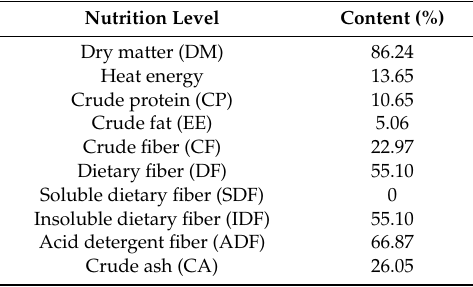
Table 2. Nutrition levels of stevia residue.